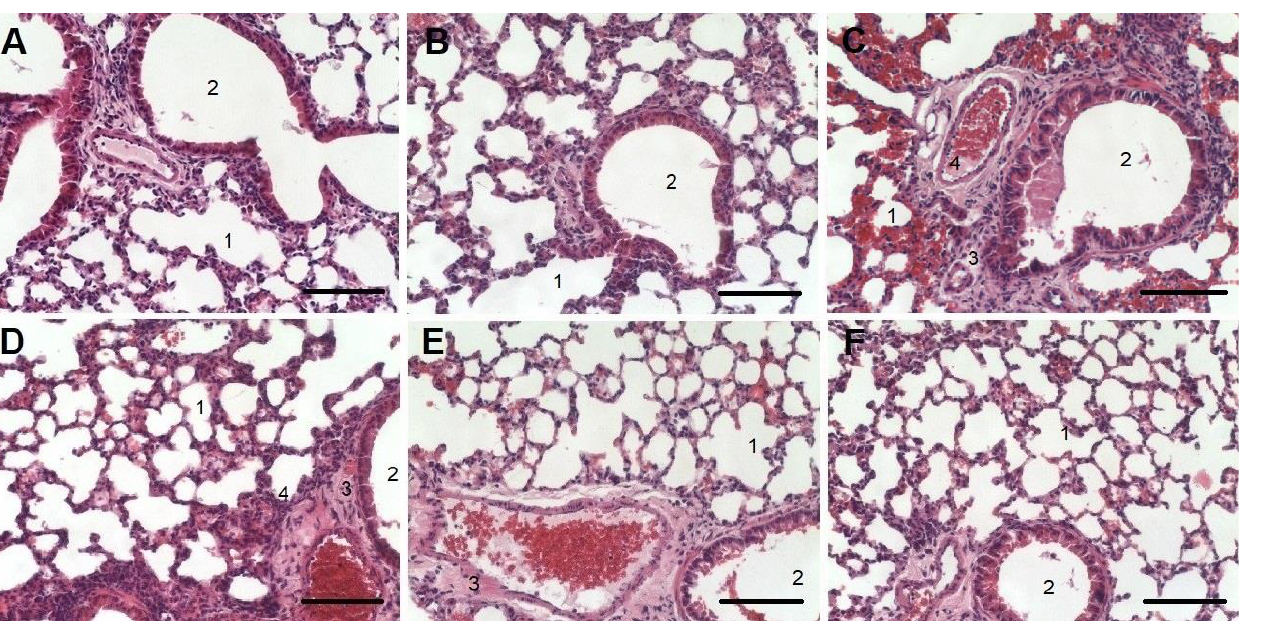
Figure 2. Histology examination of lung tissue for the Control + nSta ( A ), Control intact ( B ), and ALI ( C ) groups and for ALI groups treated with nSta inhalation (( D ) — 0.2 mg/kg, ( E ) — 0.4 mg/kg, ( F ) — 0.6 mg/kg) stained with hematoxylin and eosin. Magnification × 20. Scale —100 μm. 1 — alveoli; 2 —